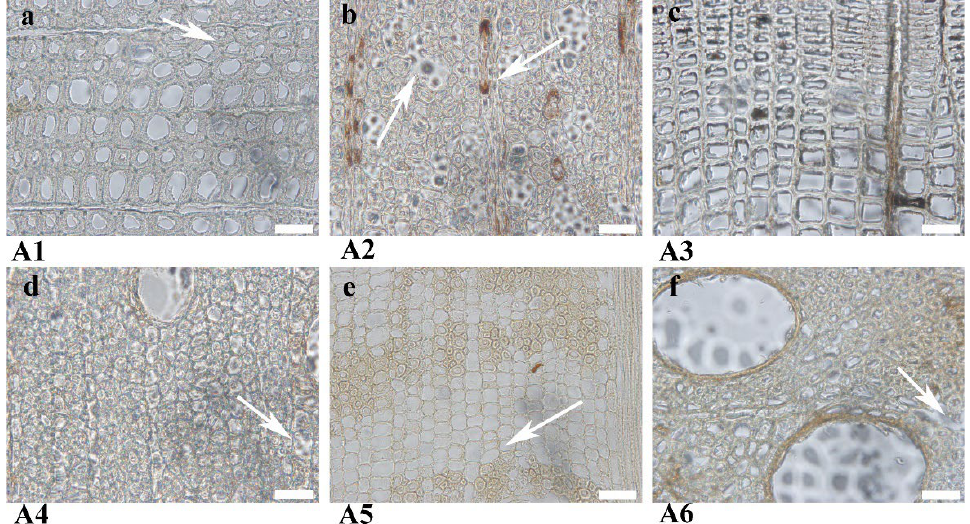
Figure 5. Microscope image of waterlogged archaeological wood (( a ), mason pine; ( b ), sweet gum; ( c ), fir; ( d ), persimmon; ( e ), banyan; ( f ), teak).